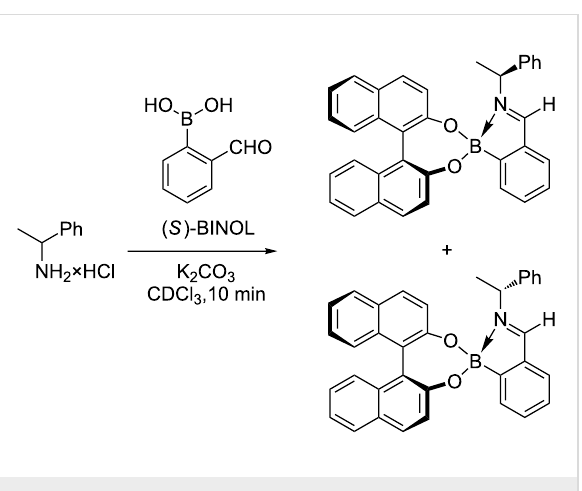
Figure 15: Chiral three component self-assembling